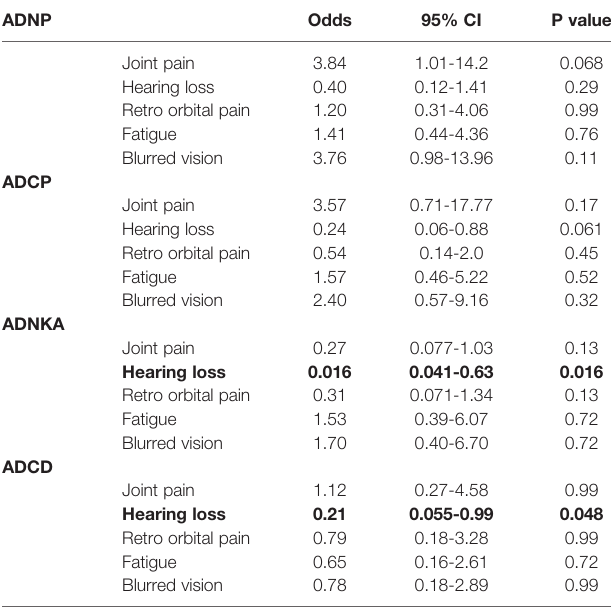
TABLE 1 | Odds ratio of BDBV survivors to suffer from long term sequelae based on positivity for antibody effector functions. ADNP Odds 95% CI P